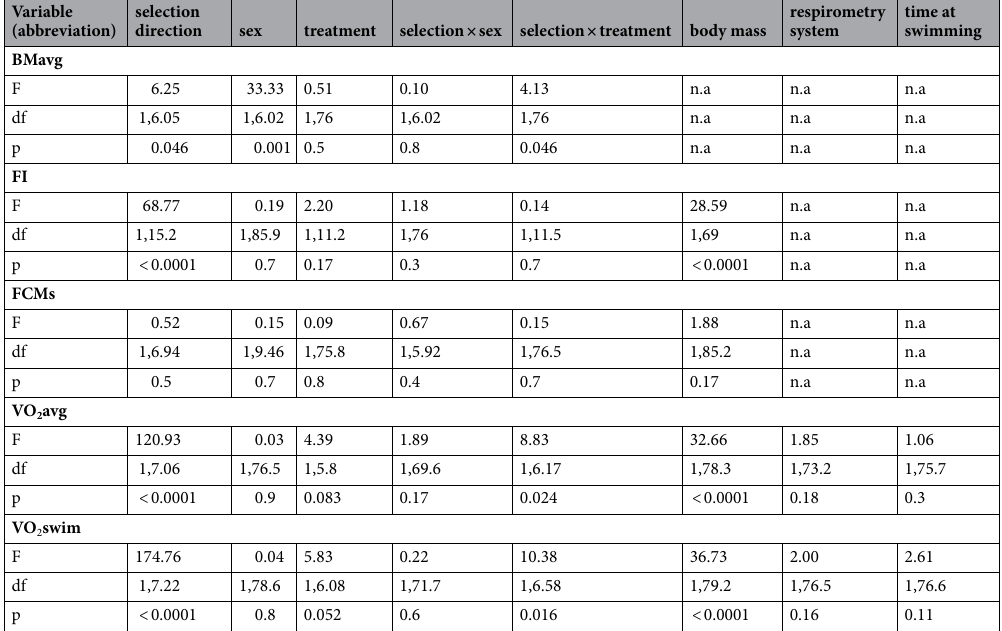
Fecal corticosterone metabolite (FCM) levels, averaged across two or four days preceding the treatment, ranged from 6.1 to 305.2 ng/g (C-lines: 68.7 ± 64.6 ng/g, A-lines: 49.1 ± 24.0 ng/g, Supplementary Table S2, Fig. 3g). There were no significant differences between selection directions, sexes or animals assigned to the two CMS treatment groups (Table 3, Fig. 3h). The values of VO 2 avg, measured at the onset of the treatment, ranged from 1.40 to 7.20 ml O 2 /min (C lines: 2.96 ± 0.63 ml O 2 /min, A lines: 5.50 ± 0.69 ml O 2 /min) and VO 2 swim ranged from 2.11 to 7.41 ml O 2 /min (C lines: 3.34 ± 0.54 ml O the mass-adjusted VO 2 avg and VO 2 swim were higher in the A than in C lines ( p < 0.0001). A-line voles assigned to the CMS group had a higher VO 2 avg ( p = 0.012) and VO 2 swim ( p = 0.063) than those assigned to the comfort group, but there was no such difference in C lines ( p ≥ 0.5; selection × group interaction: p ≤ 0.024, Fig. 4b,e). Analyses set 3: The effects of chronic mild stress (CMS) treatment. Because some characteristics differed between the CMS groups already before the treatment was applied, the effects of the CMS treatment and other results from this set of analyses are reported as either percent change or ratio between in-experiment and the initial values, measured before the CMS vs comfort treatment was applied. The percent change of BMavg from its initial value ranged from -11.3 to 13.7% and tended to be higher in the A lines (mean ± SD: C lines: 0.7 ± 4.6%, A lines: 2.3 ± 3.0%; p = 0.070, Fig. 3c, Table 4), but did not differ between sexes ( p = 0.97). The values were higher in the second than in the first week of the treatment ( p < 0.0001). CMS treatment did not affect body mass changes ( p = 0.13), and the effect of selection × treatment interaction was not significant ( p = 0.3). The scope of change of further traits was not affected significantly by body mass ( p ≥ 0.5, except for VO 2 avg, for which a positive trend appeared, p = 0.078), and did not differ systematically between sexes ( p ≥ 0.18) or the two treatment weeks ( p ≥ 0.7). The interactions present in the models but not mentioned in the text below were not significant ( p ≥ 0.2). Within all traits the repeated measures factor of individual was significant ( p ≤ 0.001, Supplementary Table S3). Except for FCMs, in-experiment changes in all traits varied among replicate lines ( p ≤ 0.058). The changes in FI varied among experimental blocks ( p < 0.0001). The percent change of FI from its initial value ranged from -25.8 to 46.3% (C lines: 5.9 ± 12.7%, A lines: -0.5 ± 9.4%). Between the first and the second treatment week the values increased in the C lines and decreased in the A lines, resulting in a considerable interaction ( p = 0.08) and nearly significant difference between the lines at the end of the treatment (first week: p = 0.4; second week: p = 0.06, Fig. 3f, Table 4). The pattern of FI changes throughout the treatment differed also between treatment groups (treatment × week interaction: p = 0.001): in